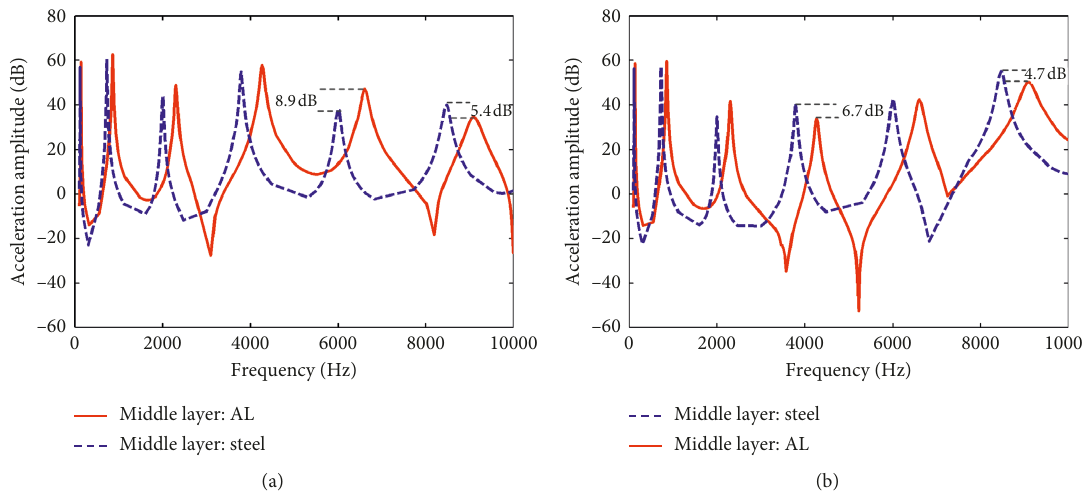
Figure 12: Effects of the middle layer material on acceleration responses: (a) ABH region ( x ( x m � 10 . 87 cm). Figure 14. The sandwich ABH beam structure was manu- factured, with the middle layer material being aluminum and the upper and lower layers being steel. The aluminum material is 2A12 aluminum alloy, and the steel material is 45 steel. The three layers of the sandwich ABH beam are bonded by thin metal glue.